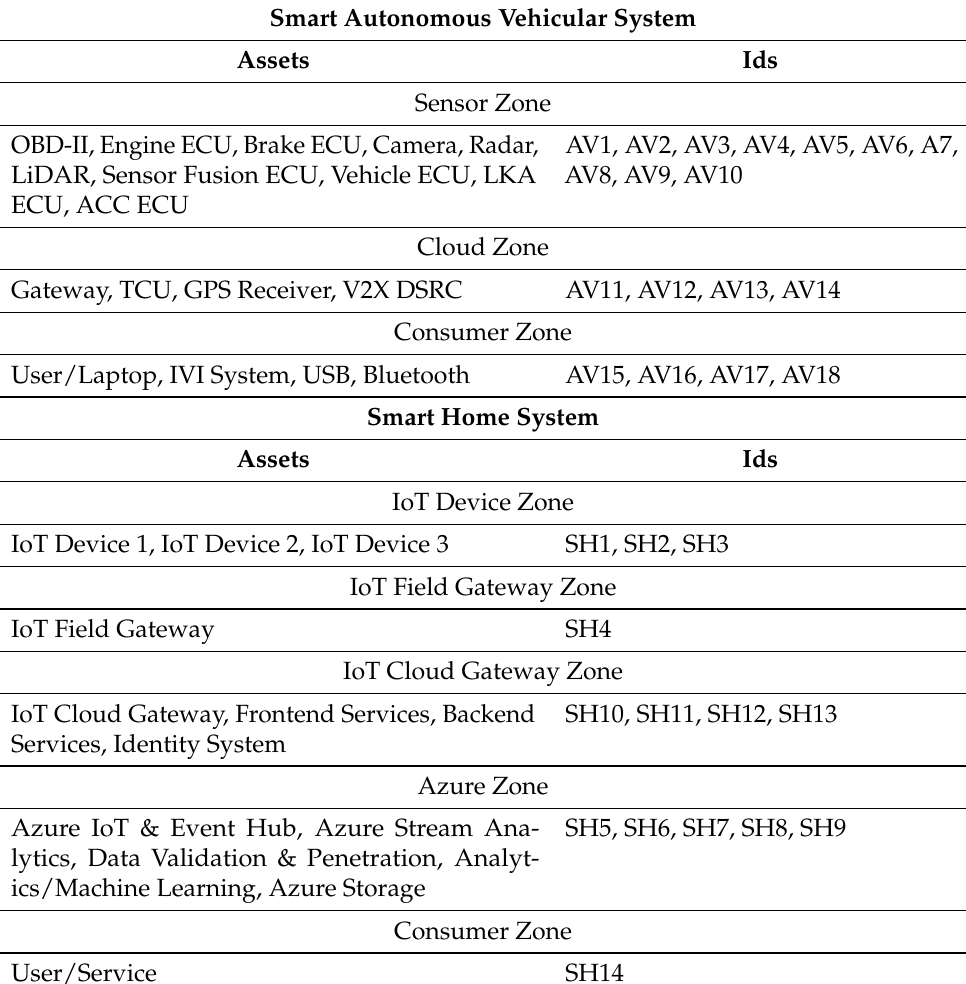
Table 2. Components Representation of Smart Use